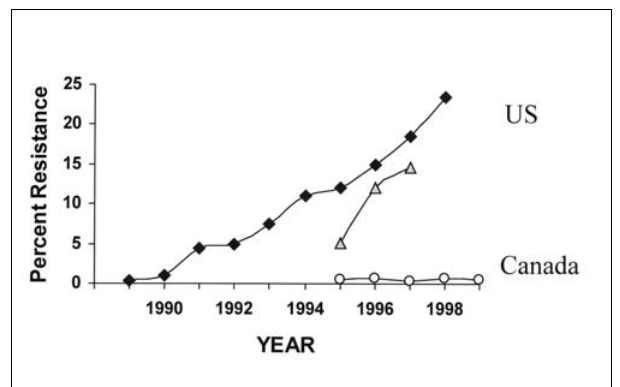
Figure 5) Vancomycin resistance among enterococci in Canada ver- sus the United States. (cid:81) 1995 to 1999 Percentage vancomycin- resistant enterococci (VRE) in all enterococcal isolates in Canada. (cid:88) 1989 to 1998 Percentage VRE in all enterococcal isolates in United States. (cid:86) 1995 to 1997 Percentage VRE in all enterococcal isolates in the United States. Data adapted from references 5, 21 and 36, the Canadian Nosocomial Infection Surveillance Program VRE Passive Reporting Network (Canadian Hospital Epidemiology Committee sites only) and VRE incidence Surveillance Program data (Canadian Hospital Epidemiology Committee sites only), 1994 to 1998 and 1999,